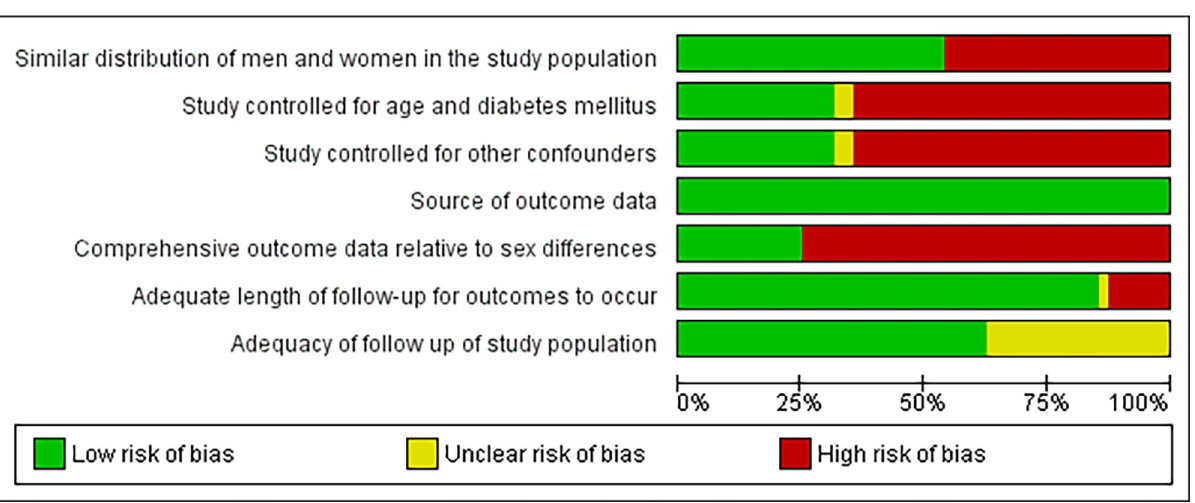
PLOS ONE | https://doi.org/10.1371/journal.pone.0254554 July 12,